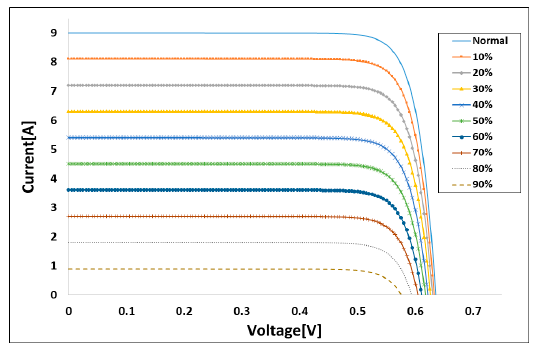
Figure 9. Current-voltage characteristic curve according to light intensity.